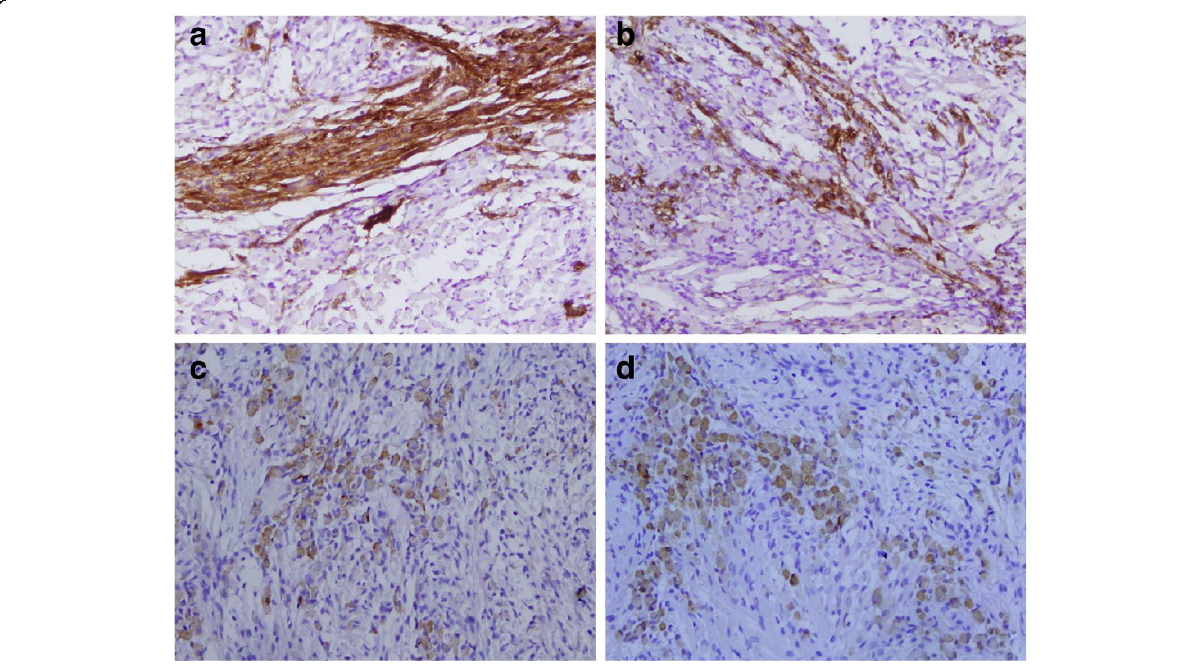
Figure 2 Immunohistochemically, the spindle cells were positive for S-100 protein (A, ×200; B, ×200 ), and the large cells were positive for desmin (C, ×200) and myoglobin (D,